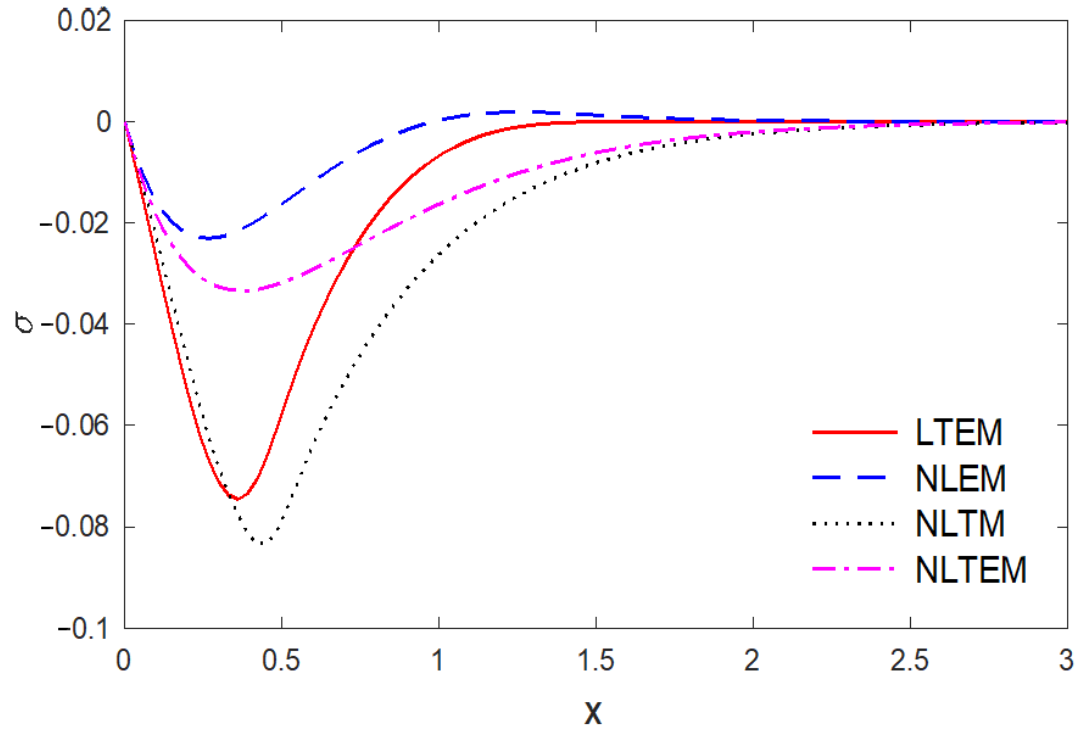
Figure 3. The stress variation via the distance for four different models.